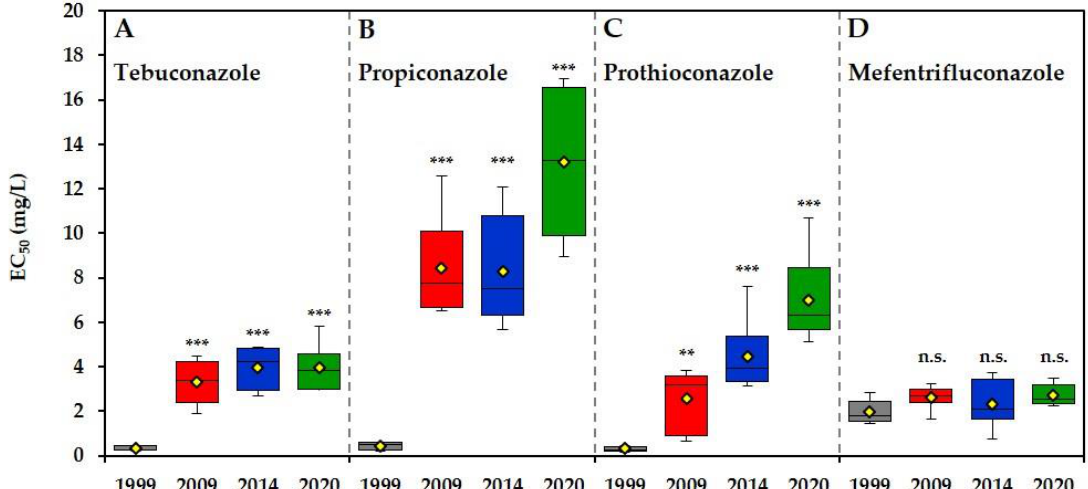
Figure 2. Changes in fungicide sensitivity (EC 50 ; mg/L) of Zymoseptoria tritici field populations isolated from wheat crops (cultivar “Ritmo”) at two locations in northern Germany between 1999 and 2020 (isolation years 1999, 2009, 2014, and 2020) to the demethylation inhibitors (DMIs) tebuconazole ( A ), propiconazole ( B ), prothioconazole ( C ), and mefentrifluconazole ( D ) using microtiter assays. EC 50 values were determined as the fungicide concentration reducing fungal growth by 50%. Boxplots and means (yellow rhombus) of EC 50 values were calculated from EC 50 values of both locations and three replications per location. Five statistics are represented in each boxplot from bottom to top: the smallest observation, lower quartile, median, upper quartile, and largest observation. Multiple contrast tests were conducted in order to compare EC 50 values of the several years (2009, 2014, and 2020) versus 1999, split for the different fungicides. Statistical significance: * = p ≤ 0.05; ** = p ≤ 0.01; *** = p ≤ 0.001. n.s. = not significant ( p > 0.05).